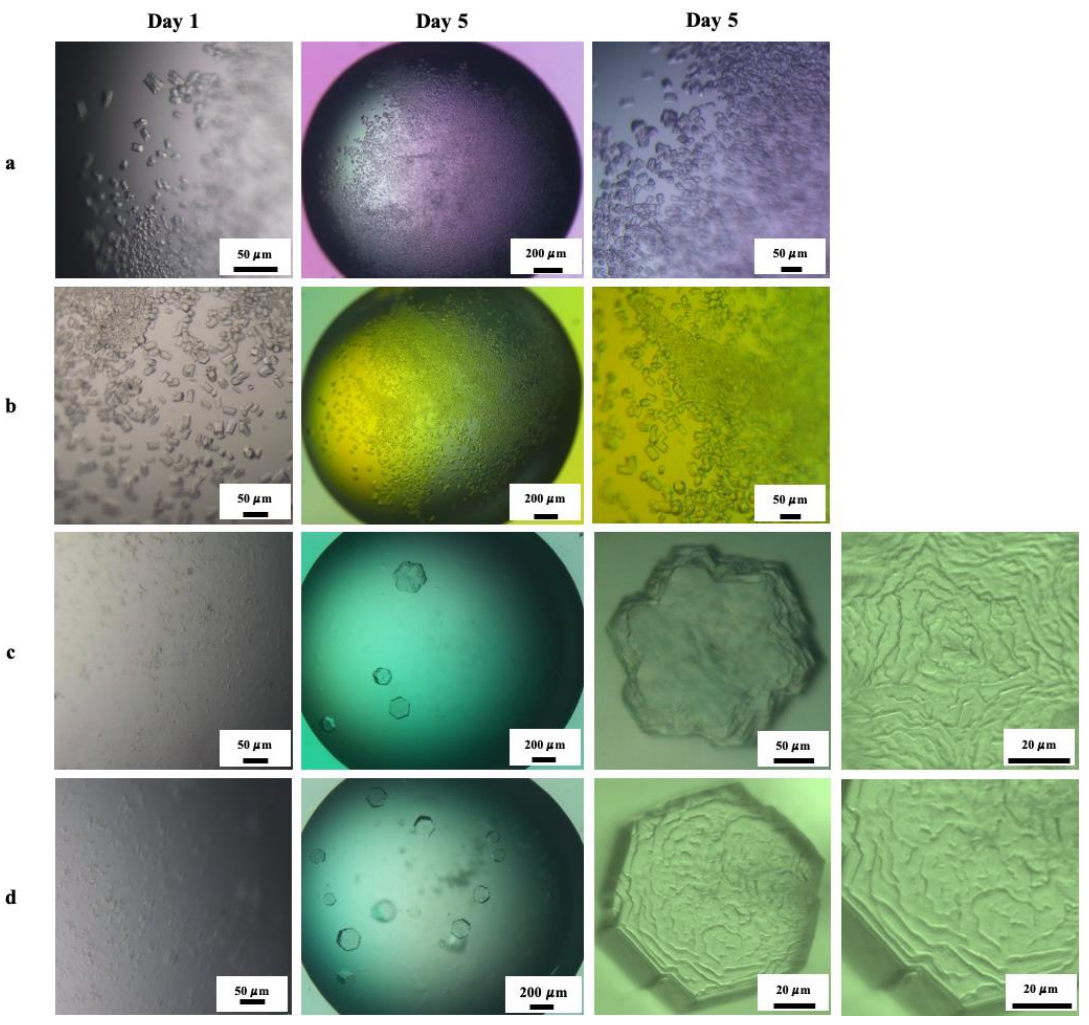
Figure 10. Crystallization of the Pdx complex ( a , b ) without and ( c , d ) with the addition of mesoscopic ordered clusters pre-induced by the pEF.